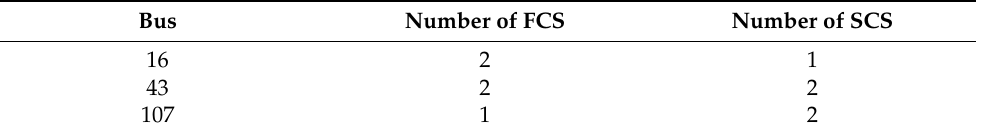
Table 11. Optimal location of CSs based on VRP index on IEEE 123 test system.